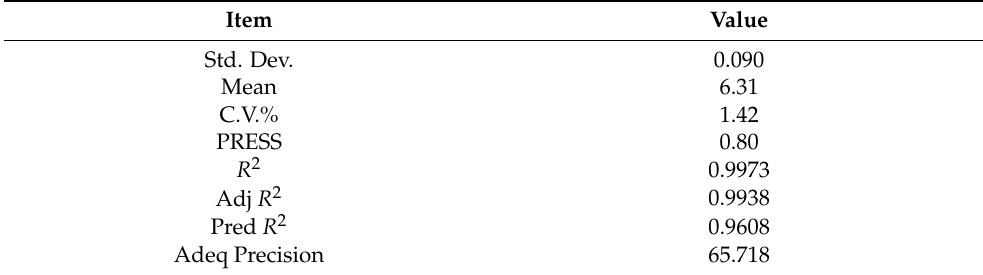
Table 4. Statistical analysis results for the regression model errors.